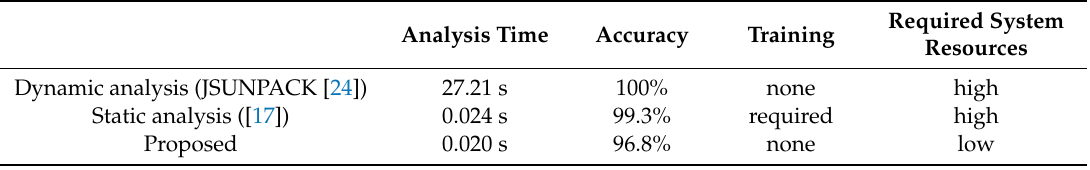
Table 9. Performance